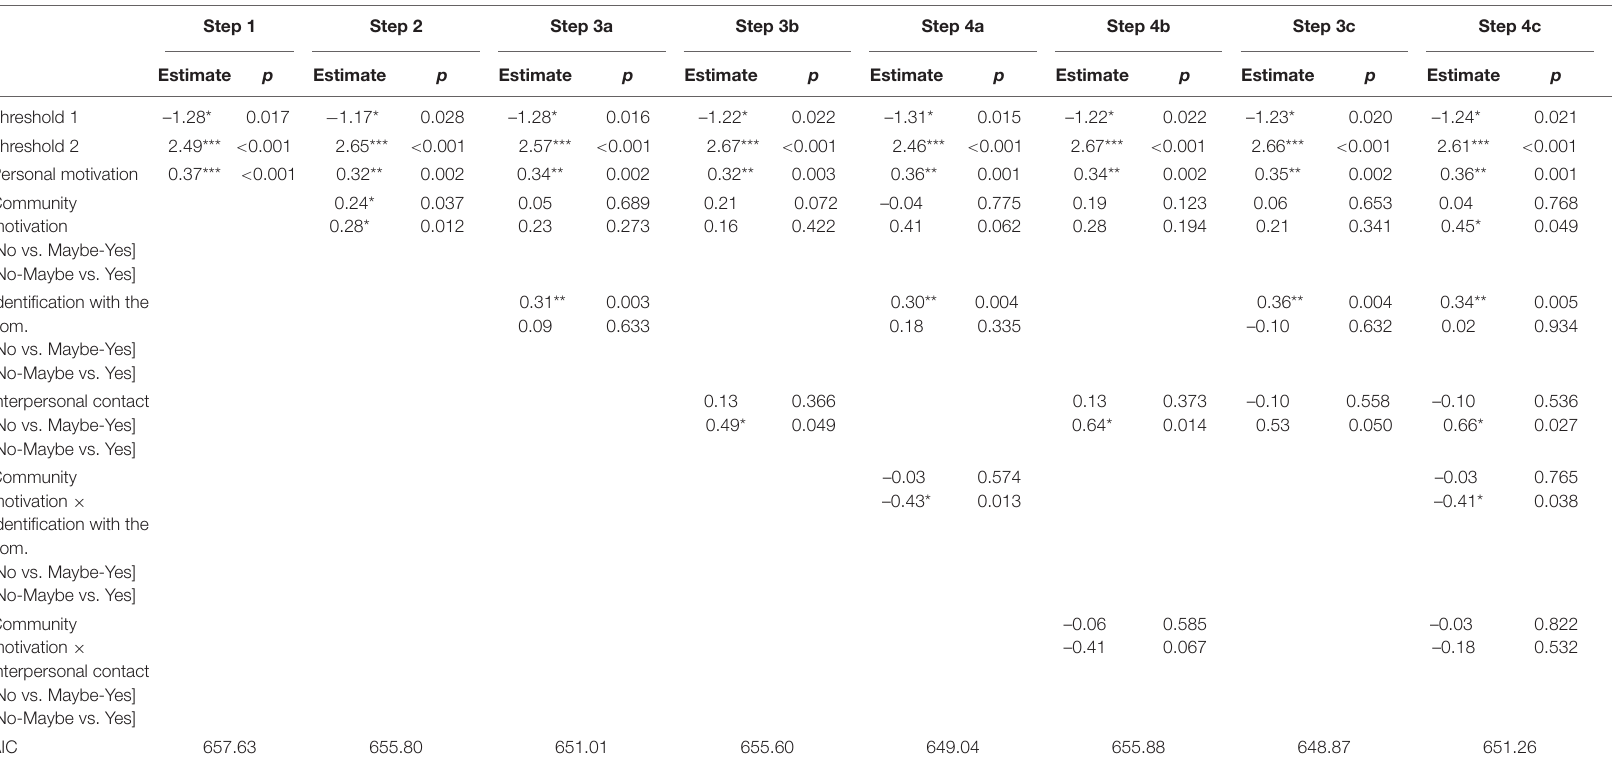
TABLE 2 | Partial proportional odds model of willingness to participate in a community energy initiatives on personal sustainable energy motivations, community sustainable energy motivation and community